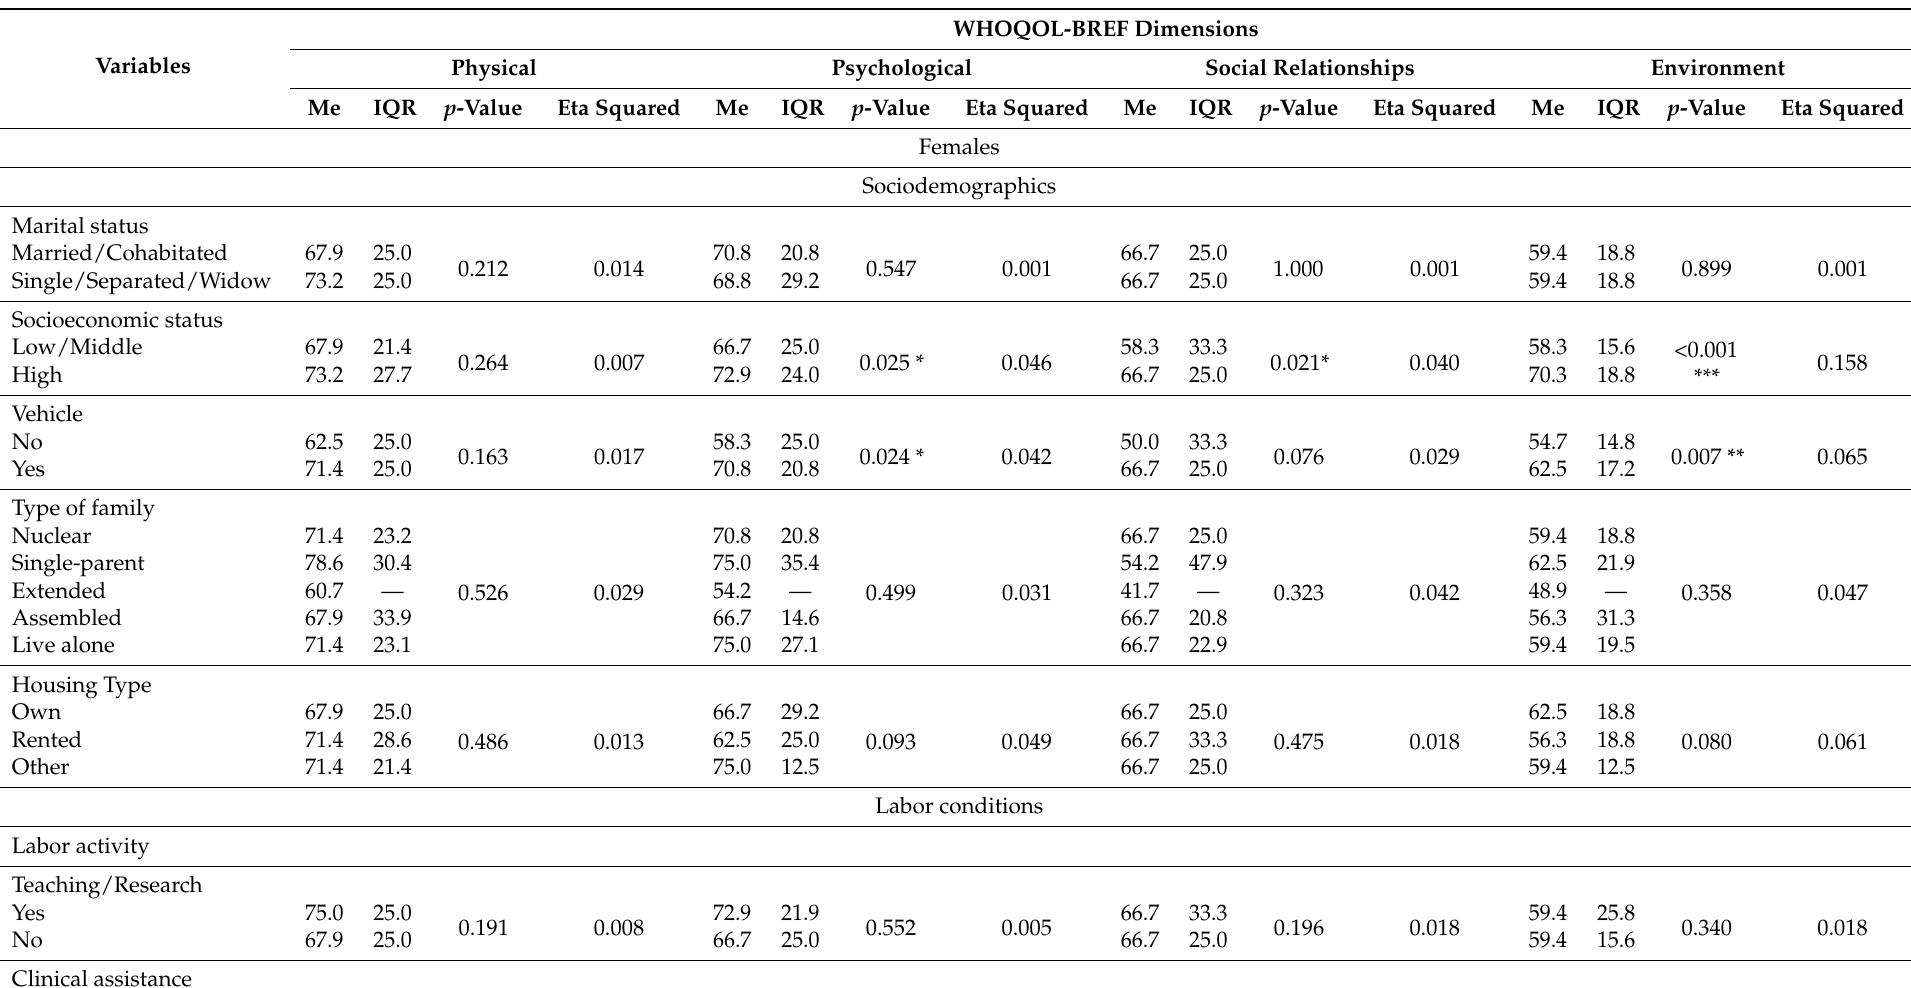
Table 1. Differences in QOL scores according to the various sociodemographic, labor, and health variables in the study sample. Medellin, 2021–2022 ( n = 187). Variables